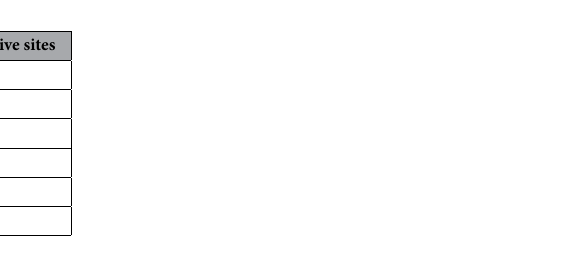
Table 2. Selection pressure (dN/dS) of npyr genes in vertebrates (p ≤ 0.05).